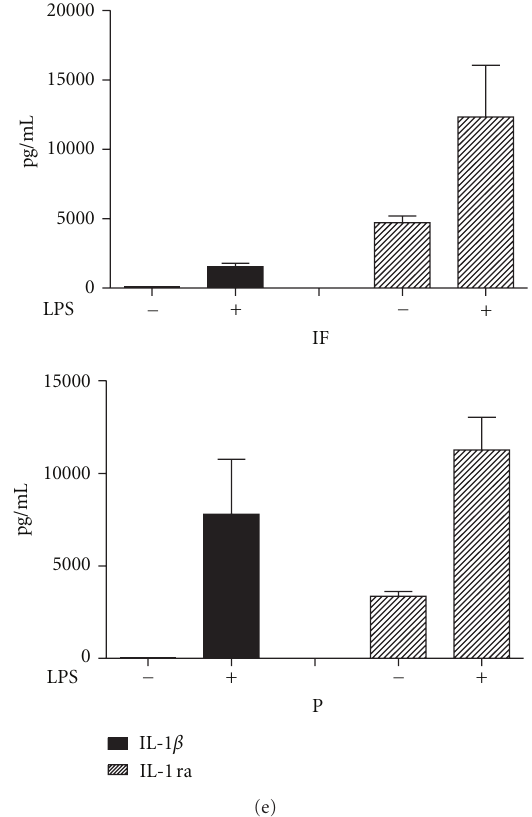
Figure 2: Peritoneal macrophages (pM φ ) were isolated from CAPD patients who were at least 3 months infection free (IF), or during an episode of infectious peritonitis (P), prior to the start of treatment with antibiotics. 1.10 6 Cells were incubated ex vivo during 24h in medium or 5 μ /mL of LPS. Cytokines were determined in supernatants or cell lysates using ELISA. (a) Pro-IL-1 β production and processing and mIL-1 β release. Quantities of pro-IL-1 β (black bars) and mature IL-1 β (mIL-1 β ) (white bars), expressed in pg/10 6 cells/24 h, using ELISA specific for either form of IL-1 β (CISTRON R ), in supernatants and cell lysates from pM φ isolated during IF-period ( n = 8) or P ( n = 10) and incubated in medium alone (a) or 5 μ /mL of LPS (b). Values are expressed as (M ± SEM). mIL-1 β levels in supernatants from LPS-stimulated pM φ s were significantly higher when cells were isolated during P ( P < 0 . 05), while pro-IL-1 β in cell lysates was decreased ( P ≈ 0 . 05). (c) total IL-1 β production ( = pro-IL-1 β + mIL-1 β in supernatants + cell lysates) expressed in pmol/10 6 cells/24 h for each IF-period (circles) and P episode (triangles) in LPS stimulated pM φ . Di ff erence between total IL-1 β production from IF and P pM φ was not statistically significant. fraction of total IL-1 β that is released in supernatant as mIL-1 β , expressed as percentage. Fractional release from peritonitis pM φ was significantly higher ( P < 0 . 005). (d) total IL-1 β production and fractional mIL-1 β release in response to increasing doses of LPS in pM φ isolated during 3 episodes of peritonitis, expressed in pmol/10 6 cells/24 h. Total IL-1 β production increased in a dose- dependent fashion. Within the range of 5.10 − 9 –5.10 − 6 g/mL, LPS induced a dose-related increase in fractional IL-1 β release. (e) release of IL-1 β and IL-1ra in supernatants from infection-free ( n = 15) and peritonitis pM φ ( n = 8) stimulated with and without 5 μ g/mL of LPS. Substantial amounts of IL-1ra were released in unstimulated cells. LPS-stimulated peritonitis pM φ released similar quantities of IL-1 β and